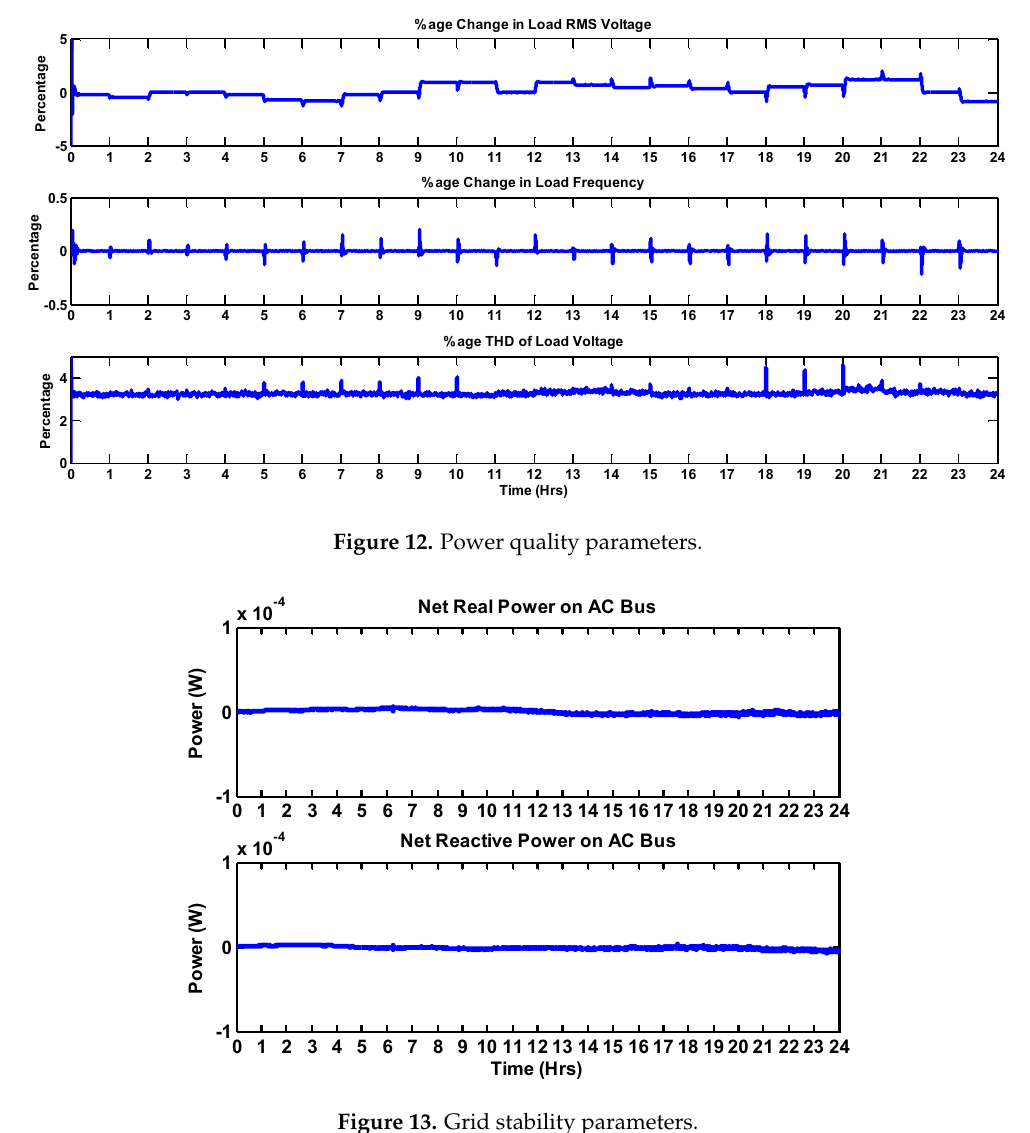
Figure 13. Grid stability parameters.